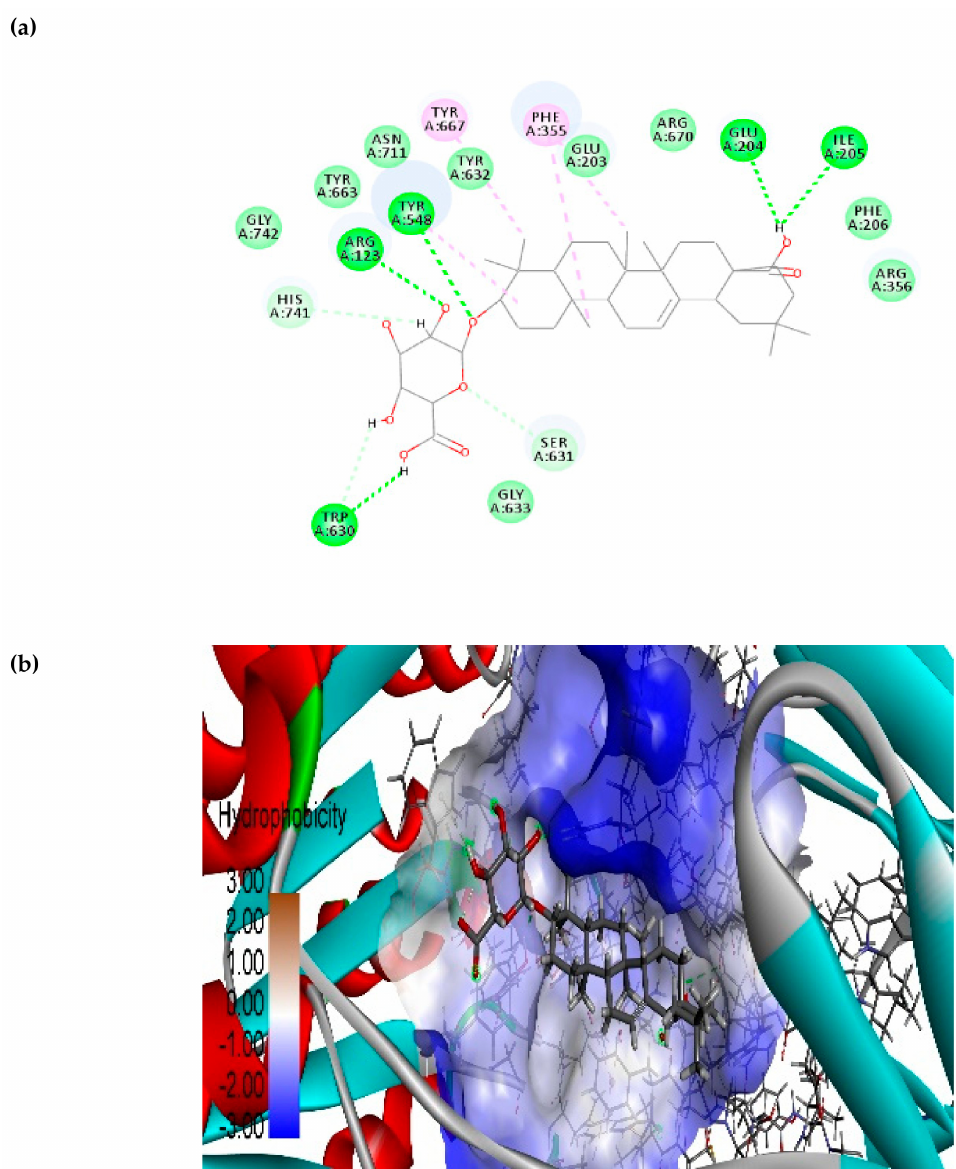
Figure 10. Phytochemical calenduloside E bound structure on DPP-4 druggable region with active site residue interacting analysis. ( a ) Two-dimensional study interaction analysis, ( b ) binding pose